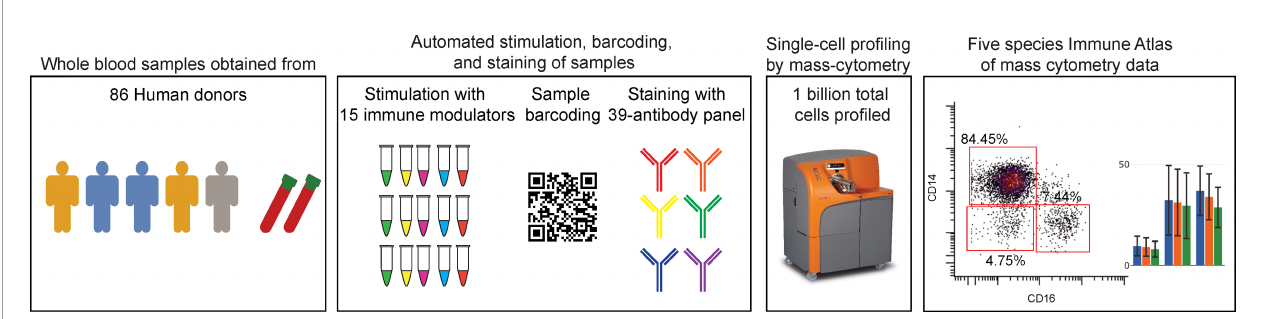
FIGURE 1 | Detailed immune pro fi ling of healthy individuals using mass cytometry. Generation of immune reference dataset. Whole blood samples were taken from 86 human donors and divided in 16 aliquots. Each aliquot was stimulated with a different cytokine, microbial agent, or left untreated. Samples were barcoded and stained with a 39-parameter antibody panel, and cells were analyzed by mass cytometry. The curated data is available as a public resource on https:// fl owrepository. org